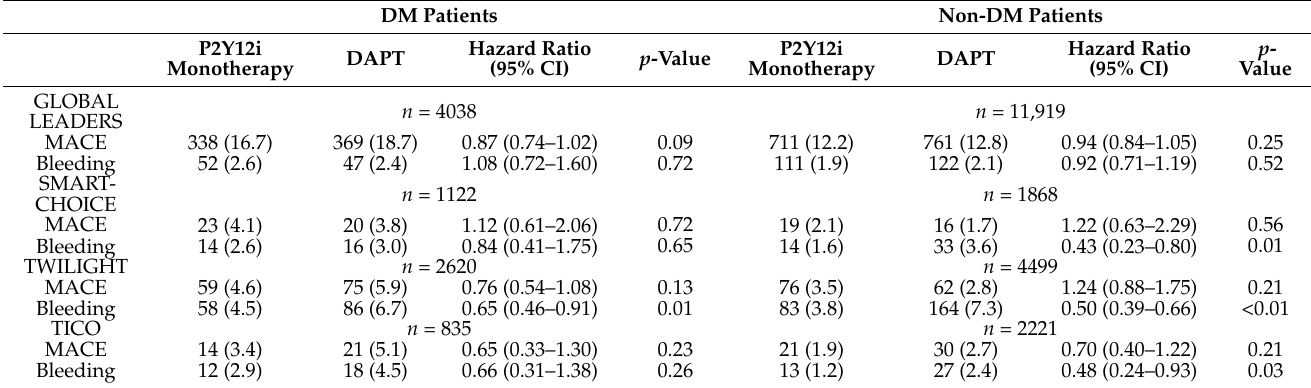
Table 2. The efficacy and safety outcomes of P2Y12 inhibitor monotherapy in patients with and without diabetes mellitus of the included randomized